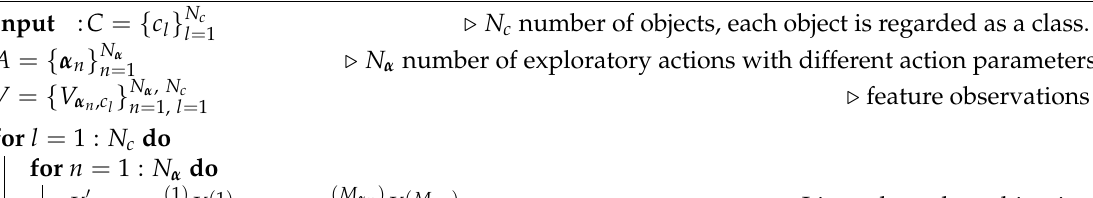
Algorithm 1 Multiple Feature Observations Combination